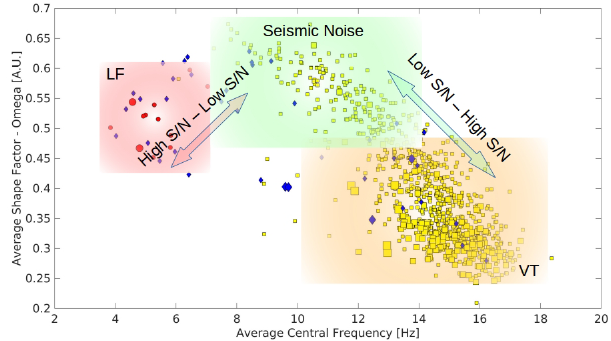
Figure 7. Spectral parameters results obtained for BKSG station. Red and yellow background areas identify the two sectors where LF and VT events are characterized by a high signal-to-noise ratio (S / N in the figure). Green background color shows the area where the waveforms are characterized by low signal-to-noise